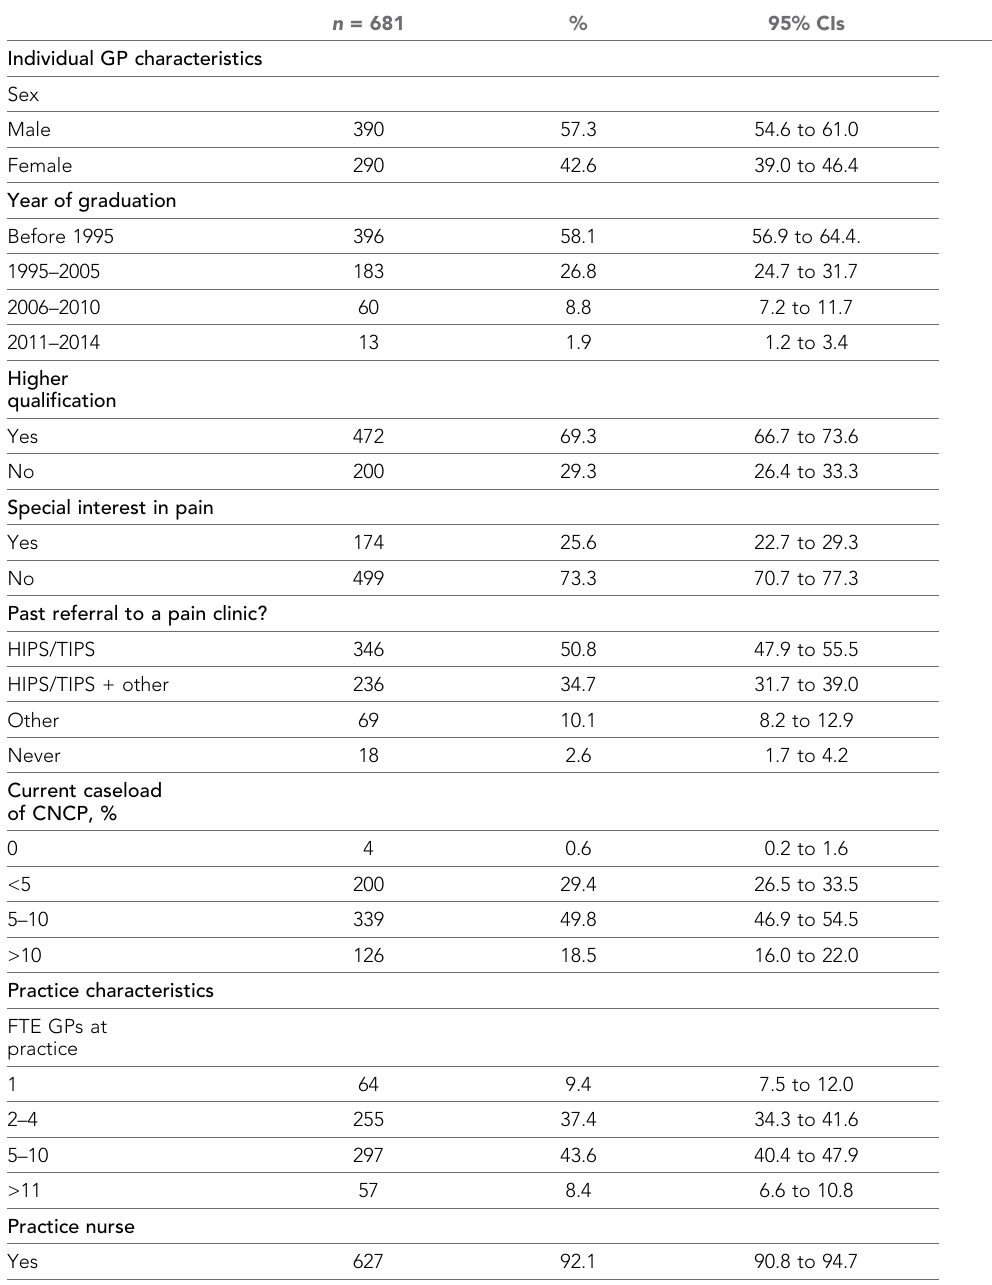
Table 1. Demographics of Hunter New England Central Coast Primary Health Network GPs n = 681 % 95%